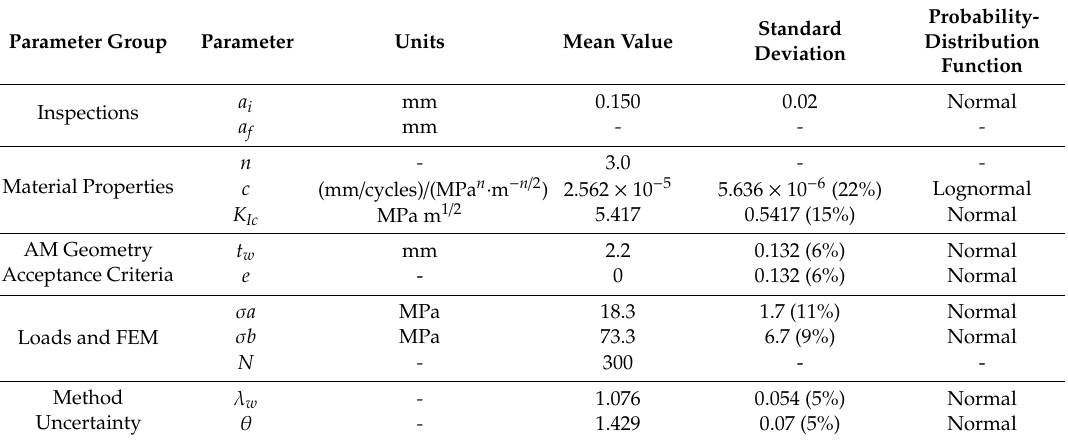
Table 2. AM-case PDF parameters considered in the